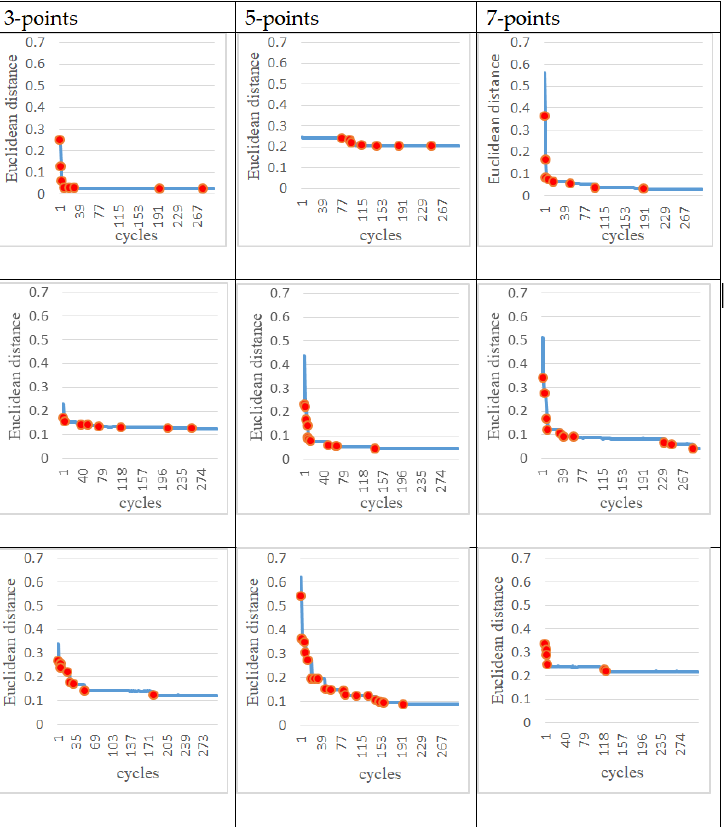
Figure 15. Learning progress of the ANM system for the target points taken from the possible range of the target